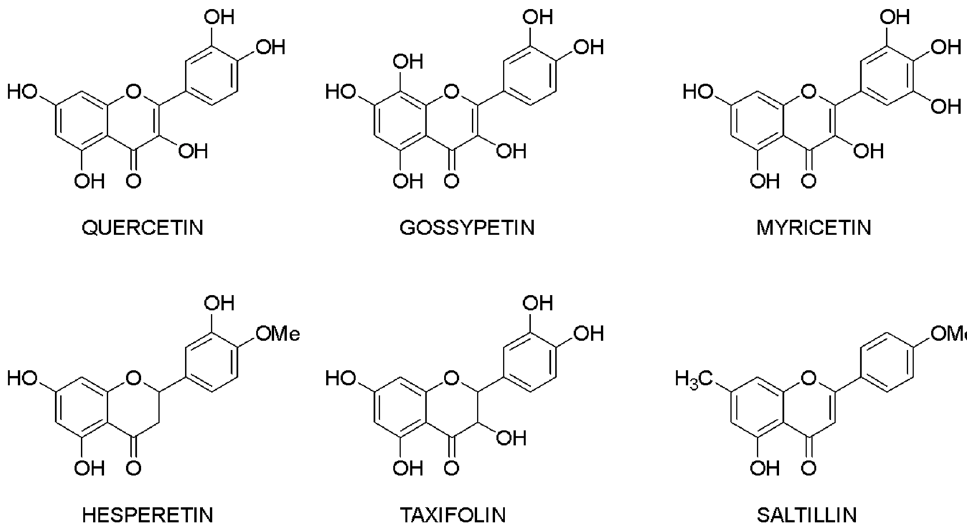
Figure 6. Lead compounds.